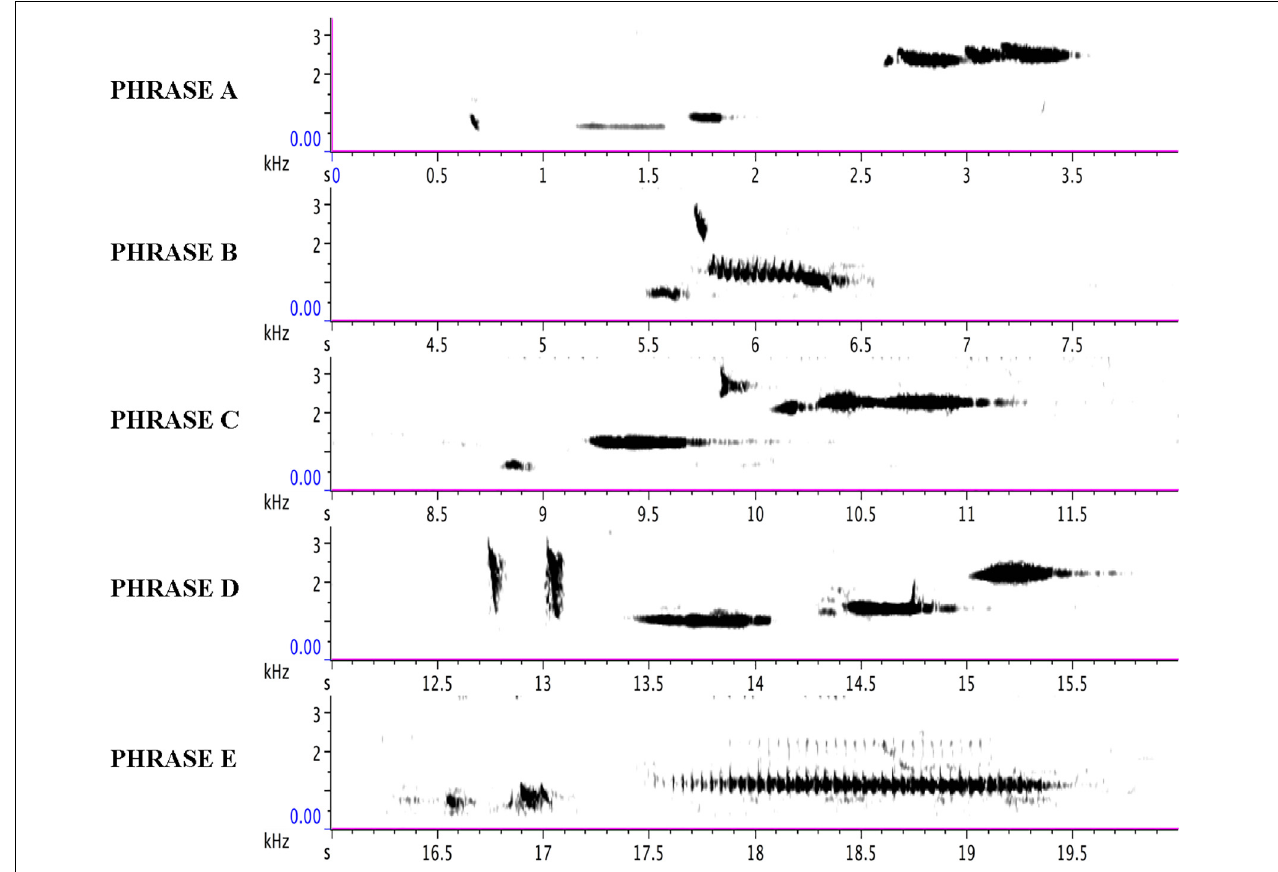
FIGURE 8 | Each line of the sonogram displays one of the five phrases (A, B, C, D, and E) of the adult bird as delivered from 13:00 to 38:58 in Supplementary Audio 2 and summarized in Supplementary Audio 3 .